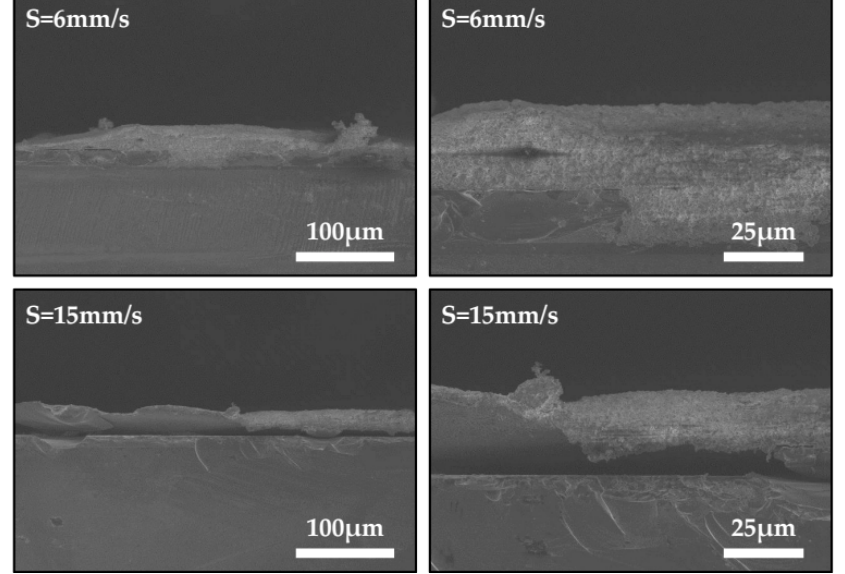
Figure 5. Images of the thickness profiles across the linear films at speeds ( S ) of 6 mm/s and 15 mm/s.